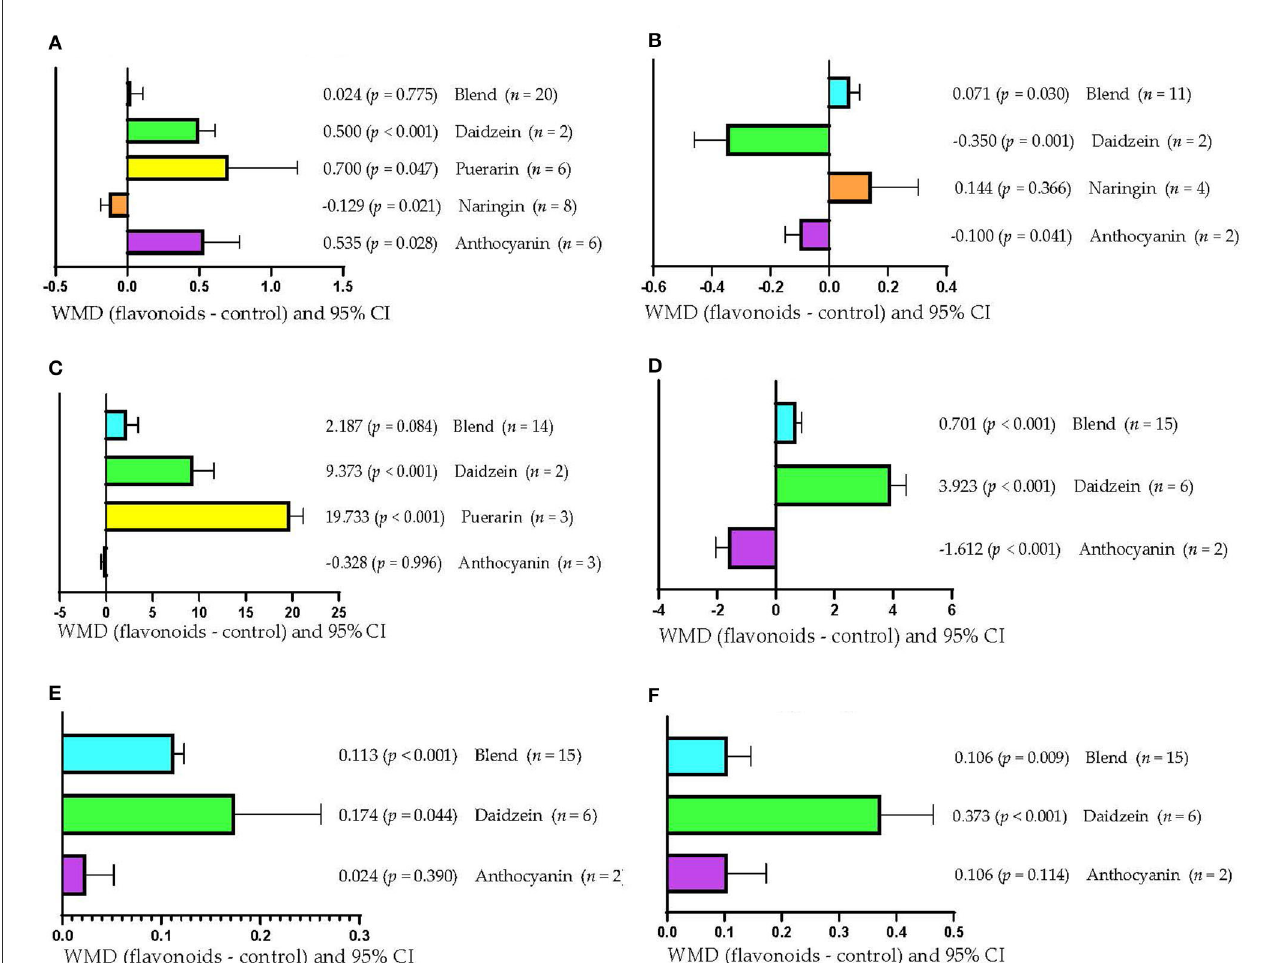
FIGURE4 Subgroup analysis (subgroup flavonoid type) of the effect of flavonoids on the diet of the cattle; WMDs, weighted mean differences between flavonoid = treatments and control. (A) Dry matter intake (DMI), kg/d. (B) Ruminal pH. (C) Superoxide dismutase (SOD), U/mL. (D) Milk production, kg/d. (E) Milk protein, g/100g. (F) Milk fat, g/100g.